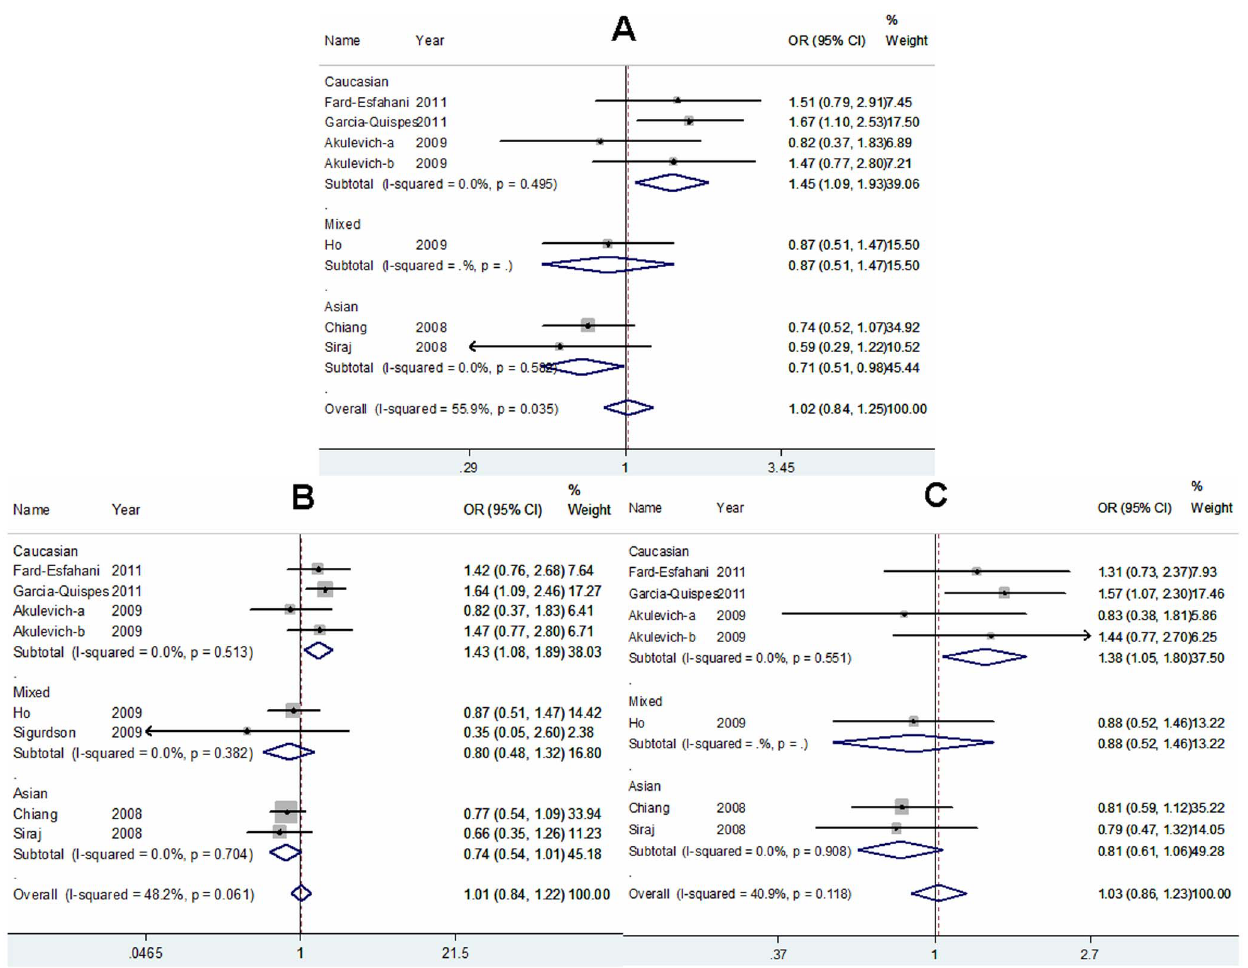
Figure 2. Forest plots of ORs with 95% CI for XRCC1 Arg280His polymorphism and the risk of DTC observed in subgroup analyses by ethnicity (fixed effects). The center of each square represents the OR, the area of the square is the number of sample and thus the weight used in the meta-analysis, and the horizontal line indicates the 95%CI. (A) Arg/His vs. Arg/Arg. (B) Dominant model. (C) Additive model.